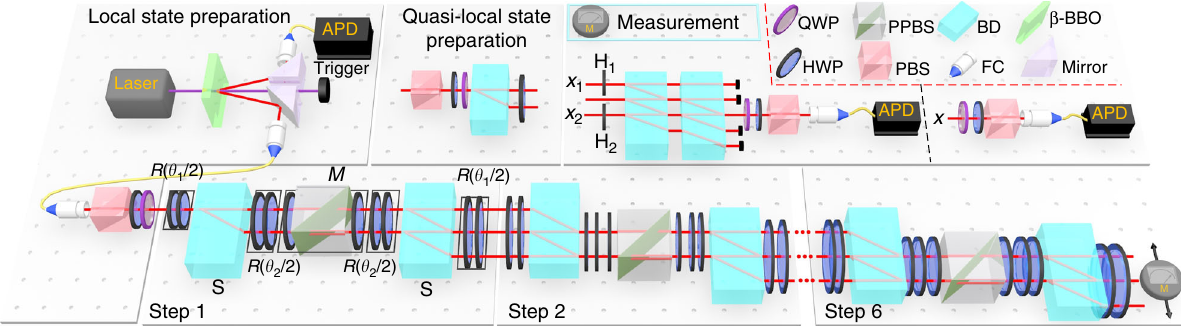
Fig. 1 Experimental setup for detecting momentum – time skyrmions in non-unitary QWs. Photons are generated via spontaneous parametric down conversion through a Type-I non-linear β -barium-borate (BBO) crystal. The single signal photon is heralded by the corresponding trigger photon and can be prepared in an arbitrary linear polarization state via a polarizing beam splitter (PBS) and wave plates. Conditional shift operation S and coin rotation R are realized by a beam displacer (BD) and two half-wave plates (HWPs), respectively. For non-unitary QWs, a sandwich-type HWP – PPBS – HWP setup is inserted to introduce non-unitarity, where PPBS is an abbreviation for partially polarizing beam splitters. Two kinds of measurements, including projective measurements and interference-based measurements, are applied before the signal and heralding photons are detected by avalanche photodiodes